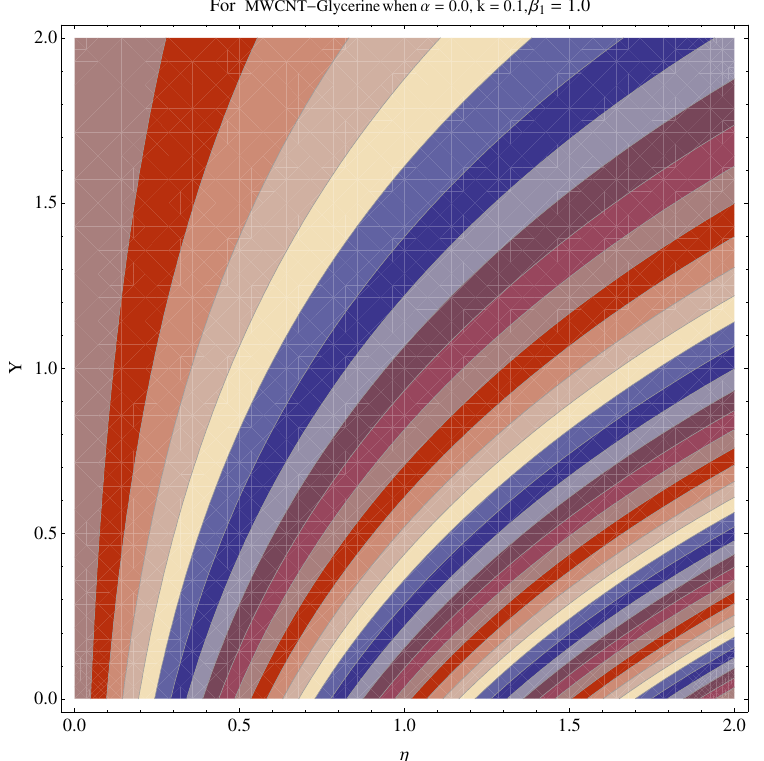
Figure 20. Contour graph at β 1 = 1.0 for